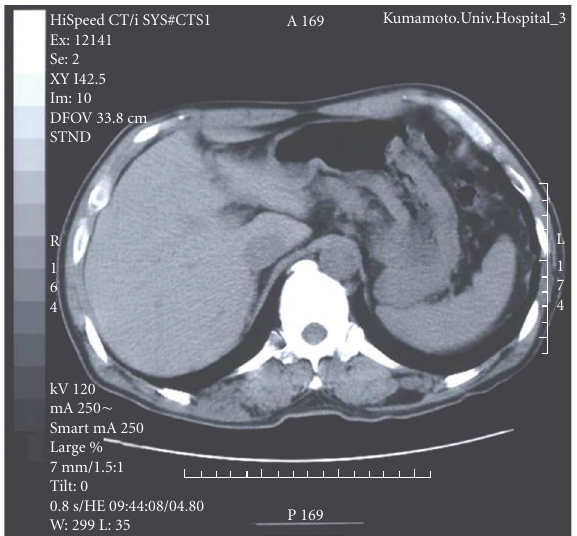
Figure 3: Normalization of CT density of the liver after 6-month discontinuation of amiodarone (63 Hounsfield